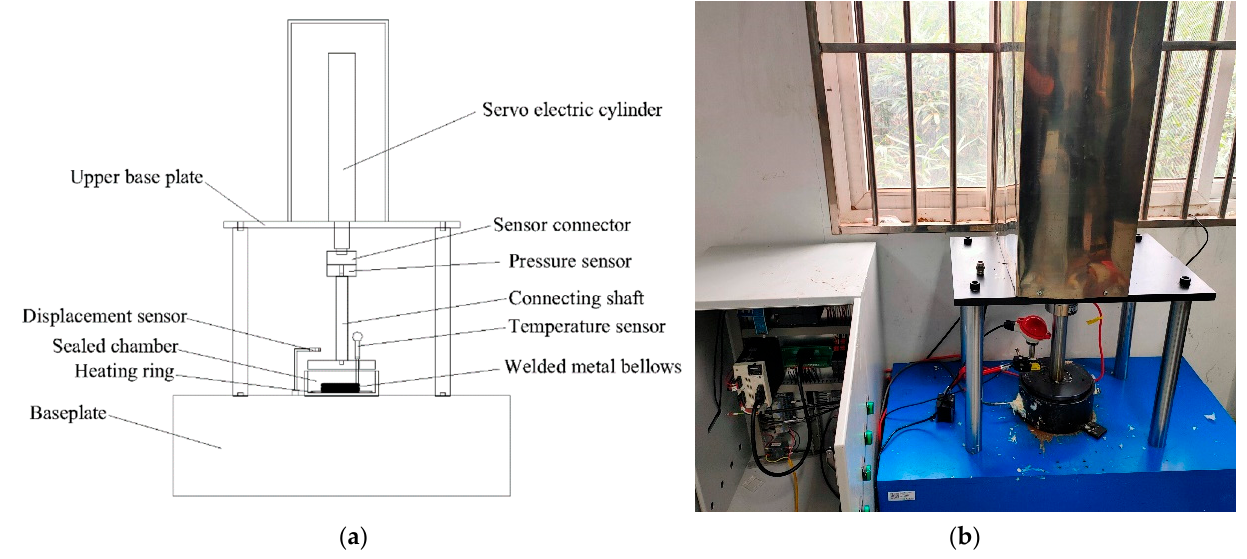
Figure 1. ( a ) Schematic diagram of stress relaxation test rig. ( b ) Physical drawing of stress relaxation test rig.